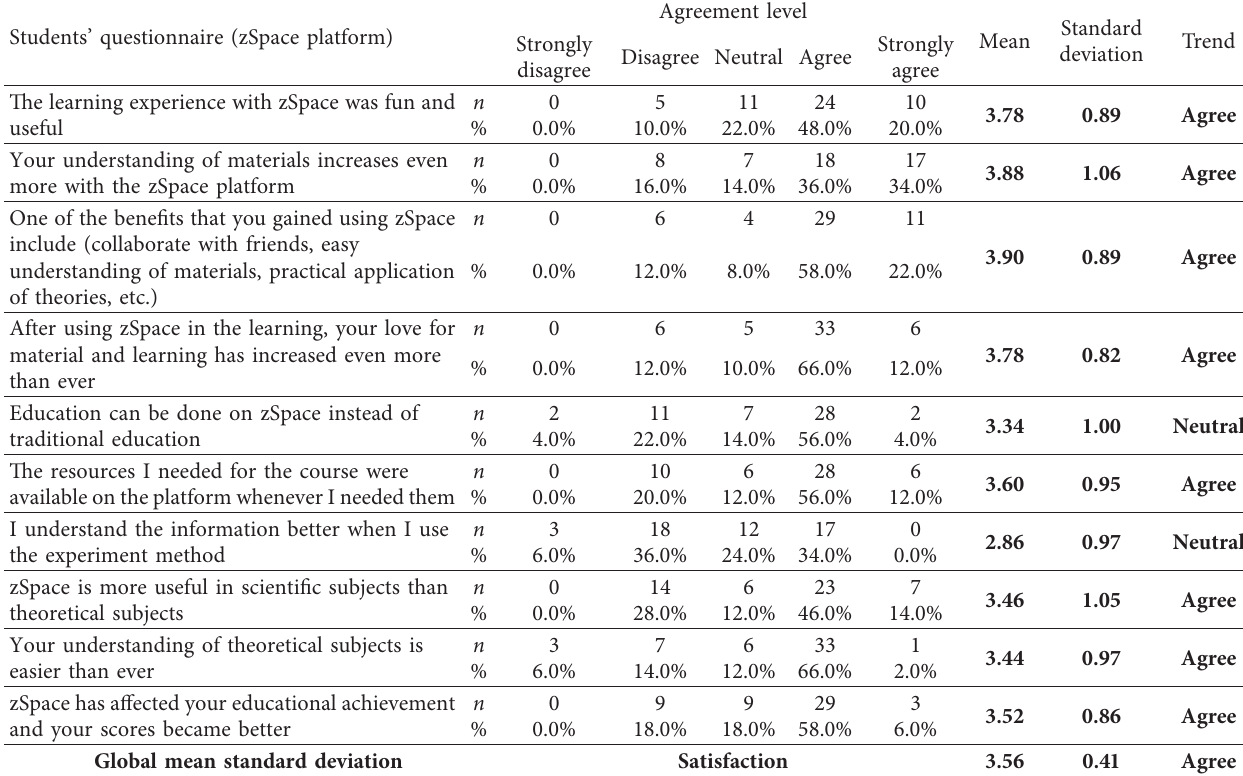
Table 9: Agreement level from the students concerned with the zSpace method.